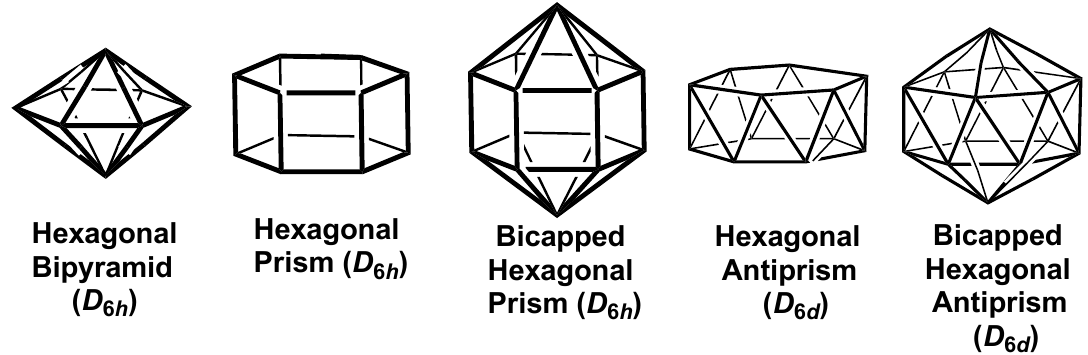
Figure 5. Hexagonal polyhedra with at least one C 6 rotation axis.